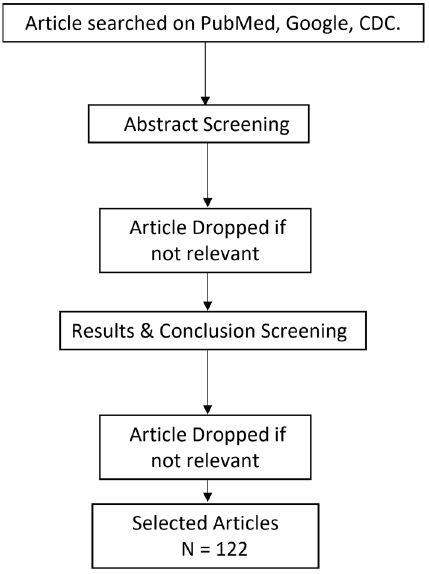
Figure 3. Flowchart for the selection of articles.